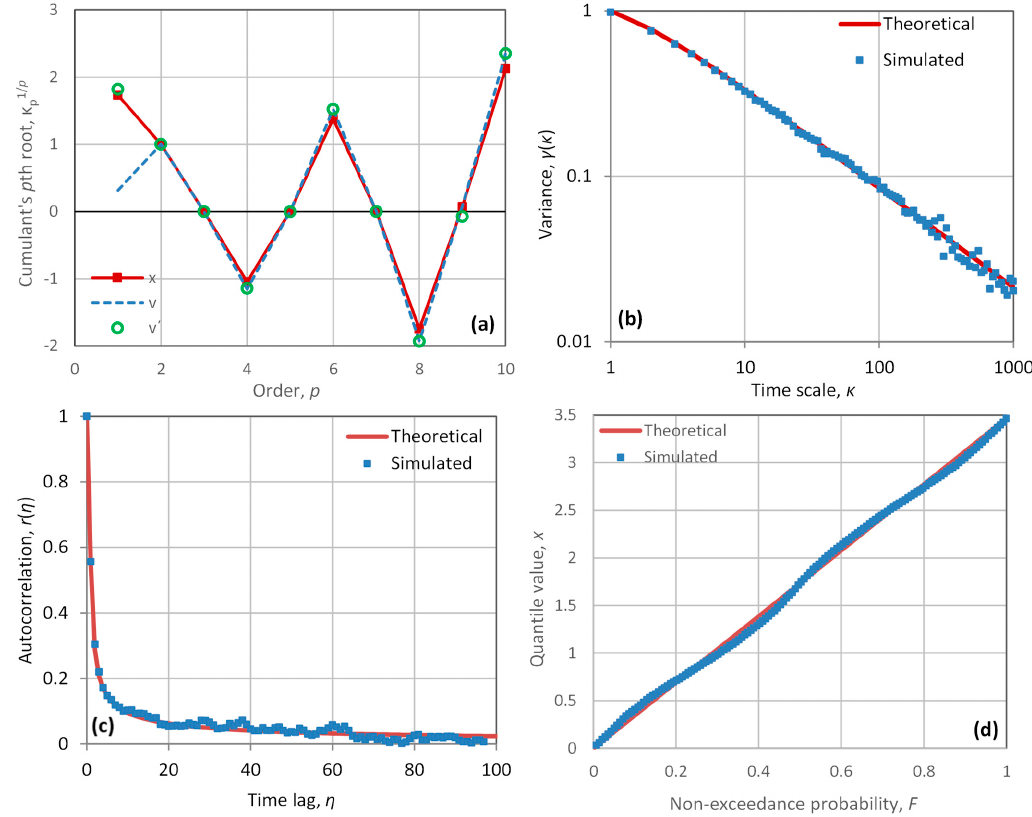
Figure 3. Graphical depiction of the results of the simulation application for a synthetic example of a persistent FHK process with uniform distribution: ( a ) cumulants; ( b ) climacogram; ( c ) autocorrelogram; ( d ) marginal distribution.